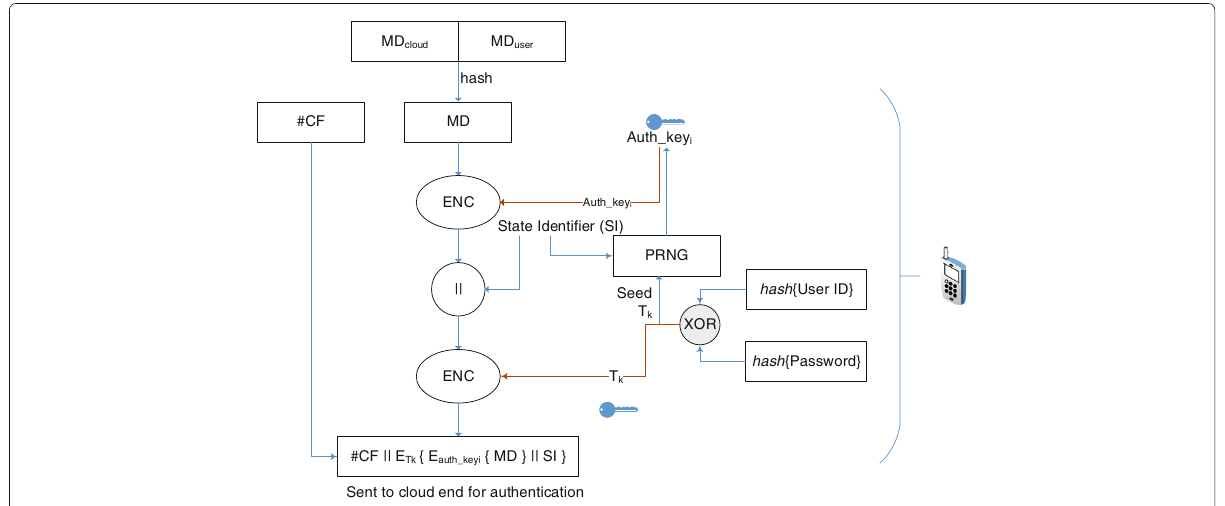
Fig. 3 Cloud server authenticates mobile device when the request is received [38] cloud server once the authentication request is